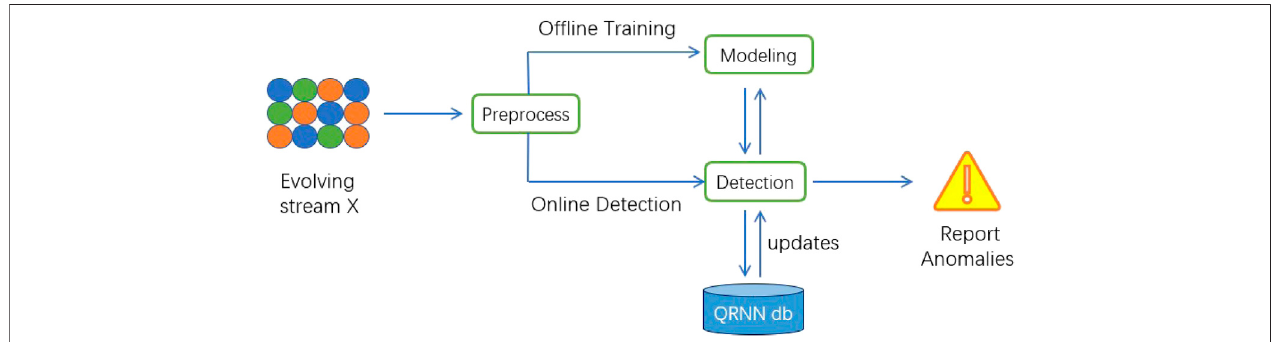
FIGURE 1 | The proposed neural network model with LSTM encoder and predictor-detector